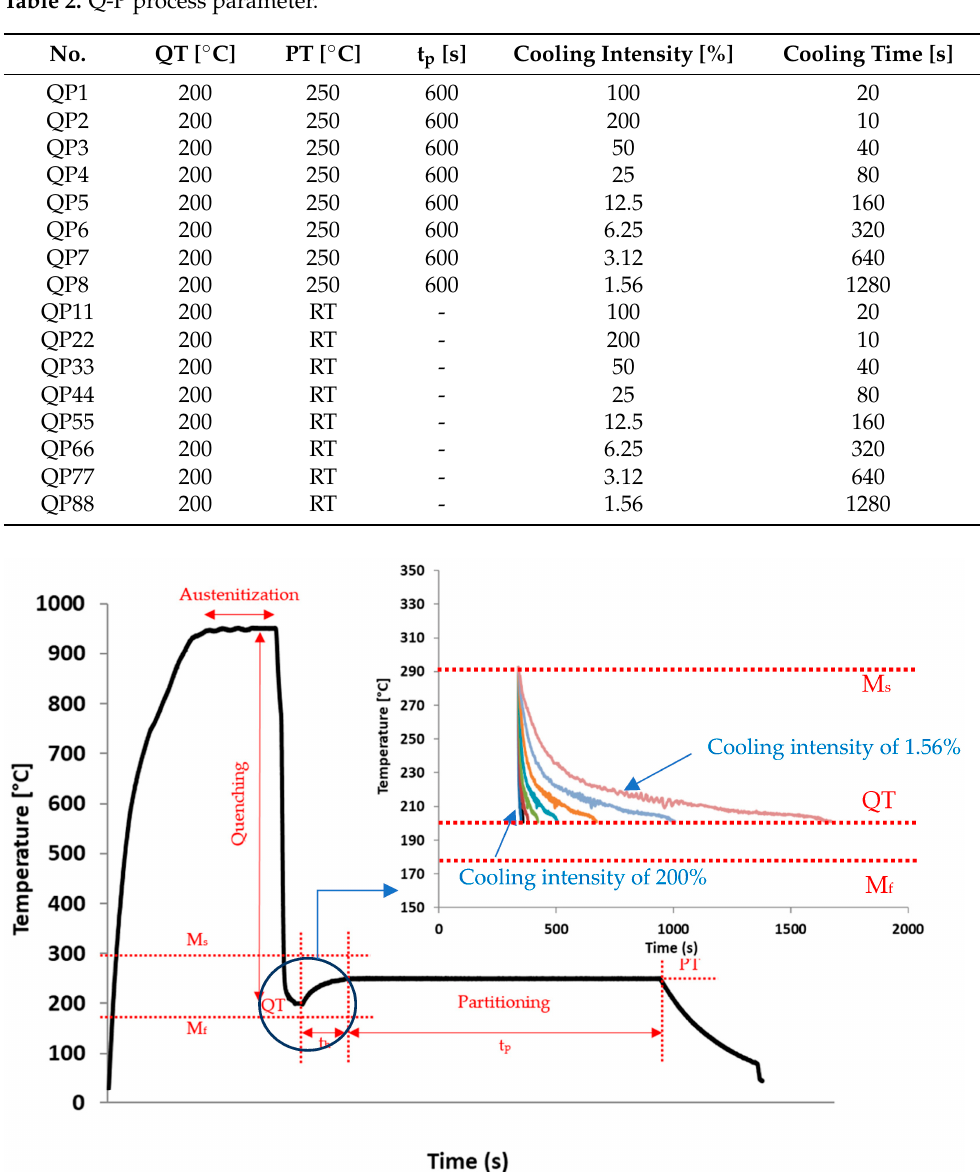
Figure 1. Schematic illustration of the Q-P process as a qualitative temperature over time plot. Table 2. Q-P process parameter.